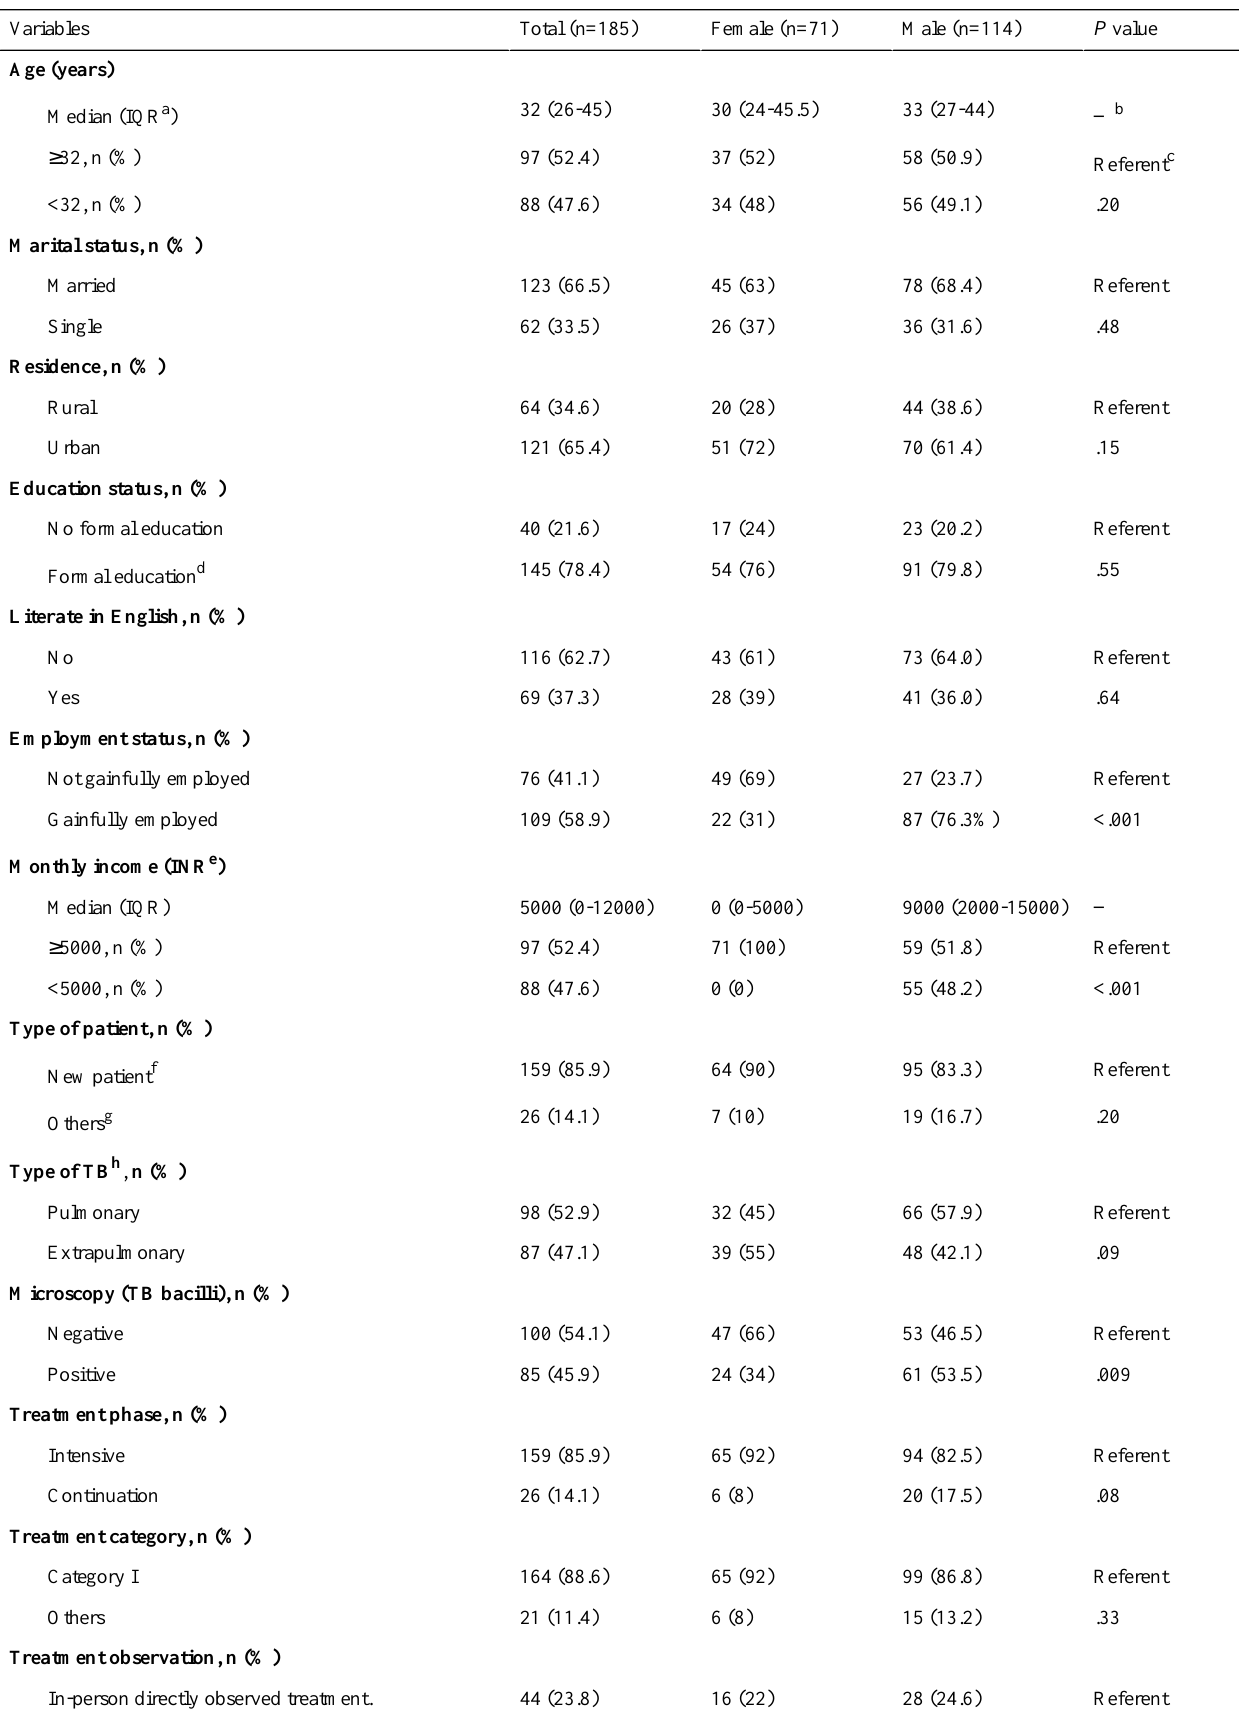
Table 1. Demographic profile of study participants